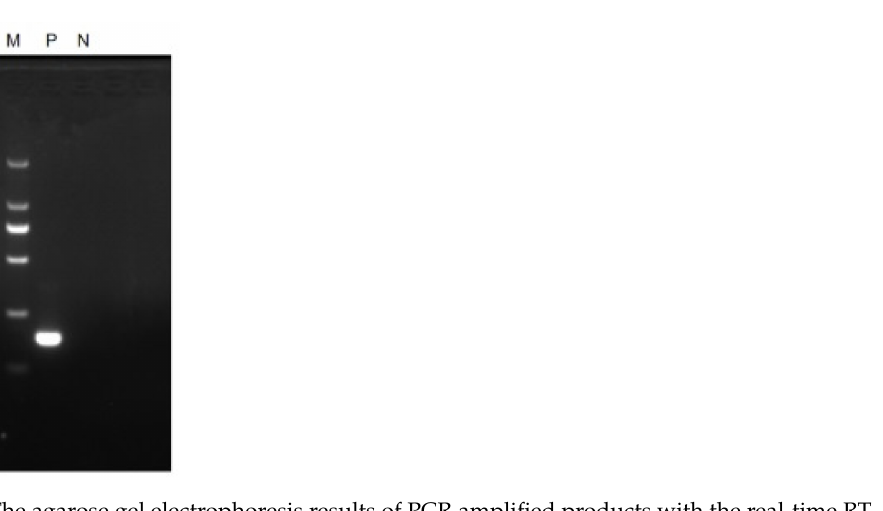
Figure 2. The agarose gel electrophoresis results of PCR amplified products with the real-time RT- RAA primers. M: D 2000 marker; P: positive control, i.e., PEDV N gene plasmid; N: negative control, i.e., ddH 2 O.